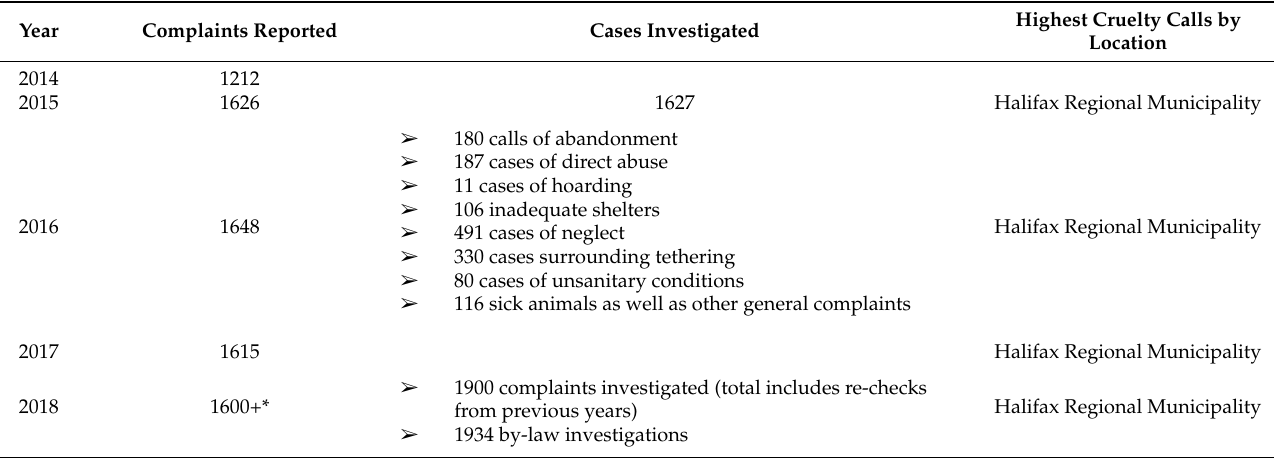
Table 6. Investigations Details from Nova Scotia. Data provided by the Nova Scotia